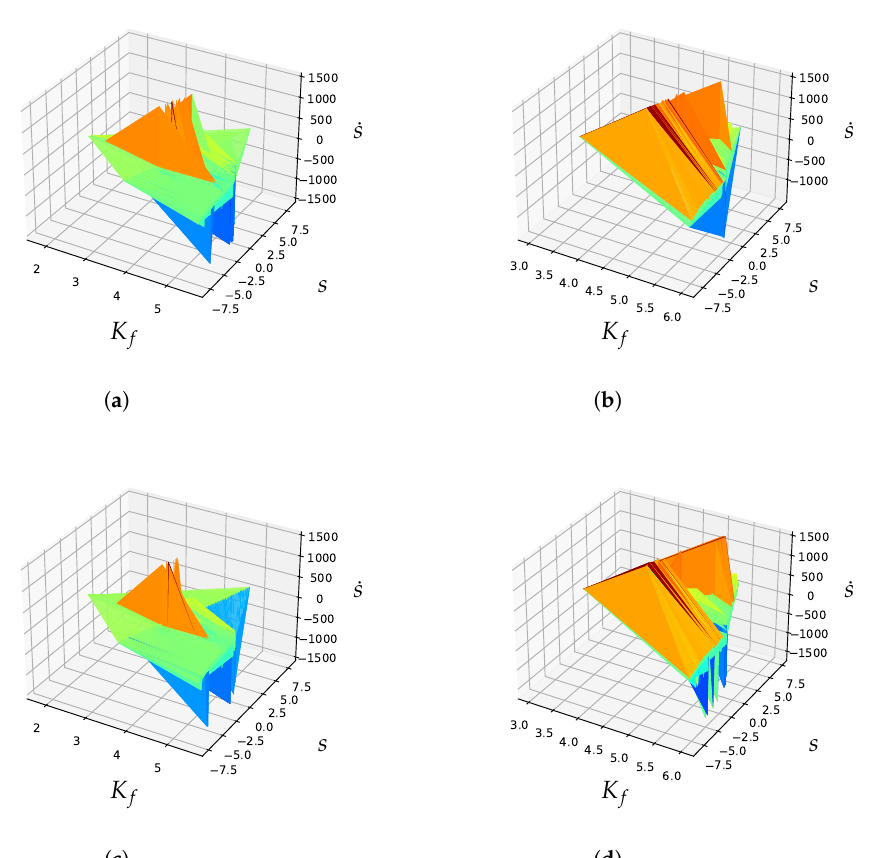
Figure 8. K f changes over s and ˙ s for left hip, left knee, right hip, and right knee: ( a ) left hip, ( b ) left knee, ( c ) right hip, ( d ) right knee.